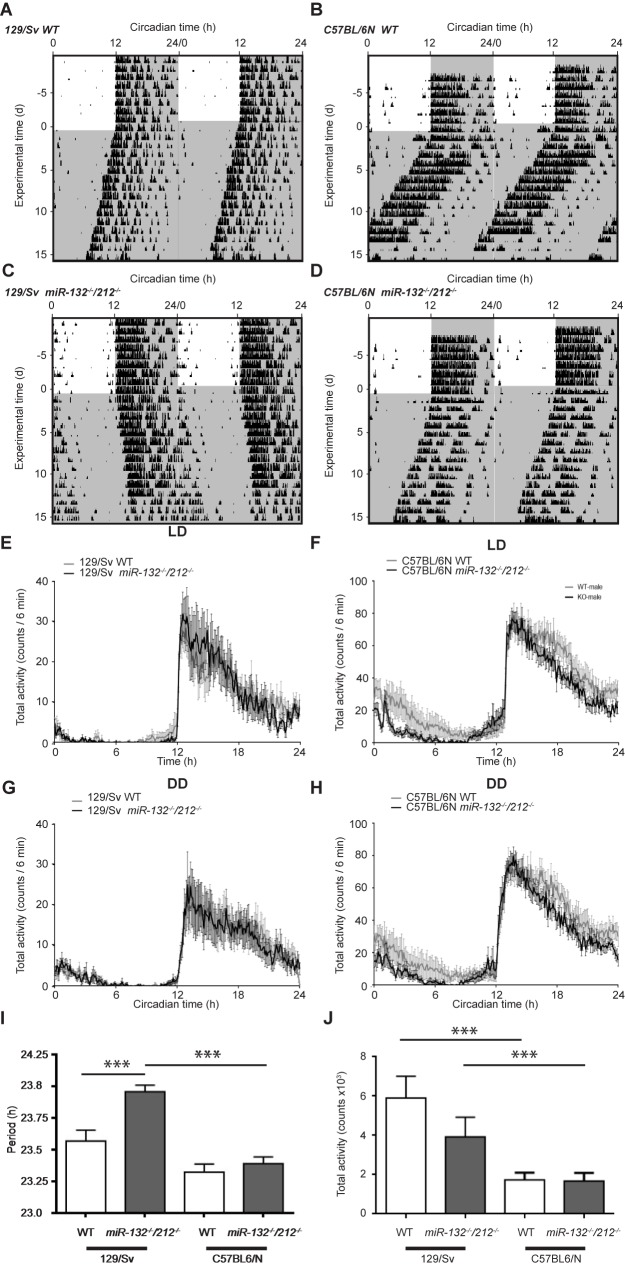
Influence of miR-132/212 deletion on the period length in constant darkness.(A-D) Representative double-plotted actograms of WT (A, B) and KO (C, D) mice in LD and DD. (E-H) Total activity profiles of WT and KO mice during LD (E, F) and DD (G, H) conditions in 129/Sv (E, G) and C57BL/6N backgrounds (F, H). (I, J) Period length (I) and total activity (J) in constant darkness for all genotypes. Period length: 129/Sv: WT: 23.57 ± 0.08 h, n = 15; KO: 23.96 ± 0.05 h, n = 15; C57BL/6N: WT: 23.32 ± 0.07 h, n = 12; KO: 23.39 ± 0.05, n = 11, two-way ANOVA for interaction F(1, 49) = 5.390, p = 0.0244, Sidak’s post-hoc test for background difference: WT: p > 0.05; KO, p < 0.001, Sidak’s post-hoc test for genotype difference 129/Sv: p < 0.001, C57BL/6N: p > 0.05. Total activity: 129/Sv: WT: 5904 ± 1104 counts, n = 7; KO: 3,921 ± 1,003 counts, n = 8; C57BL/6N: WT: 1,729 ± 376 counts, n = 8; KO: 1679 ± 408, n = 6, two-way ANOVA for genotype F(1, 31) = 1.358, p = 0.2527, two-way ANOVA for background F(1, 31) = 51.34, p < 0.001. Data are represented as mean ± SEM., * p < 0.05, ** p < 0.01, *** p < 0.001.